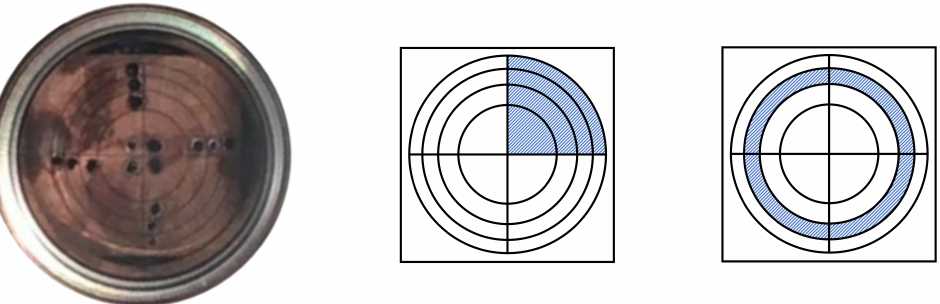
Figure 2. The segmented detector used for measuring the current of electrons and ions exiting the Gabor Lens. The detector is divided in to 16 sections of equal area which were combined in sector (middle) or concentric circle (right)